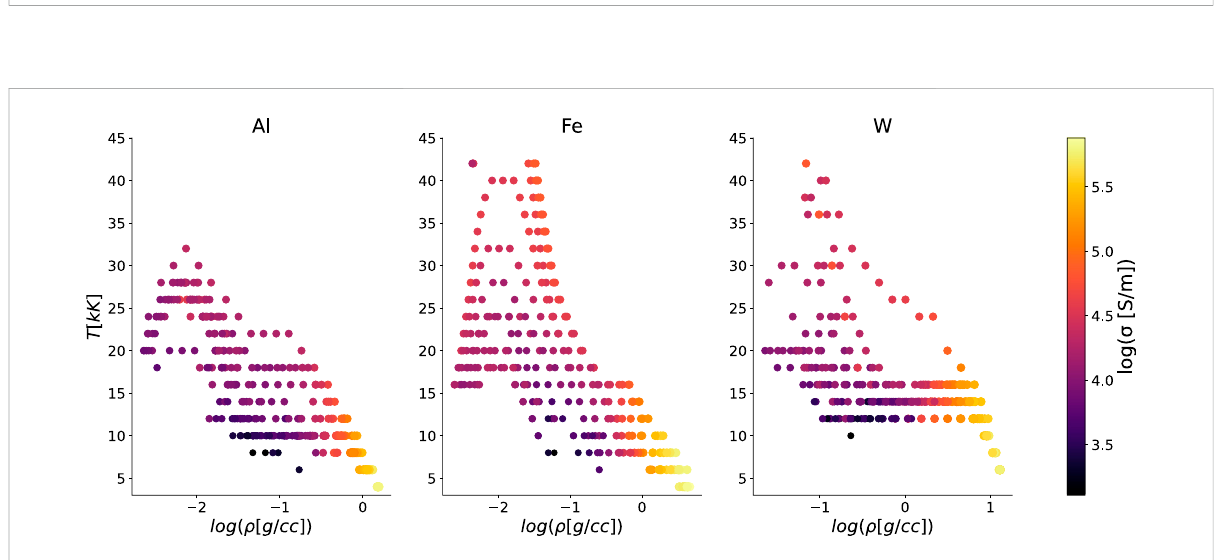
FIGURE 6 The DK data plotted as conductivity versus density (left panel) and versus temperature (right panel) for Al. In the left panel, color coding by temperaturerevealsstrongtemperaturedependenceatlowdensity,withfairlyuniversalbehaviorathighdensity.Thesetrendswithtemperaturecan be seen in the right panel, in which data points are color-coded by the logarithm of the density: conductivities decrease with temperature at high densities (top, green), are roughly constant at intermediate densities (cyan), and increase with temperature at low